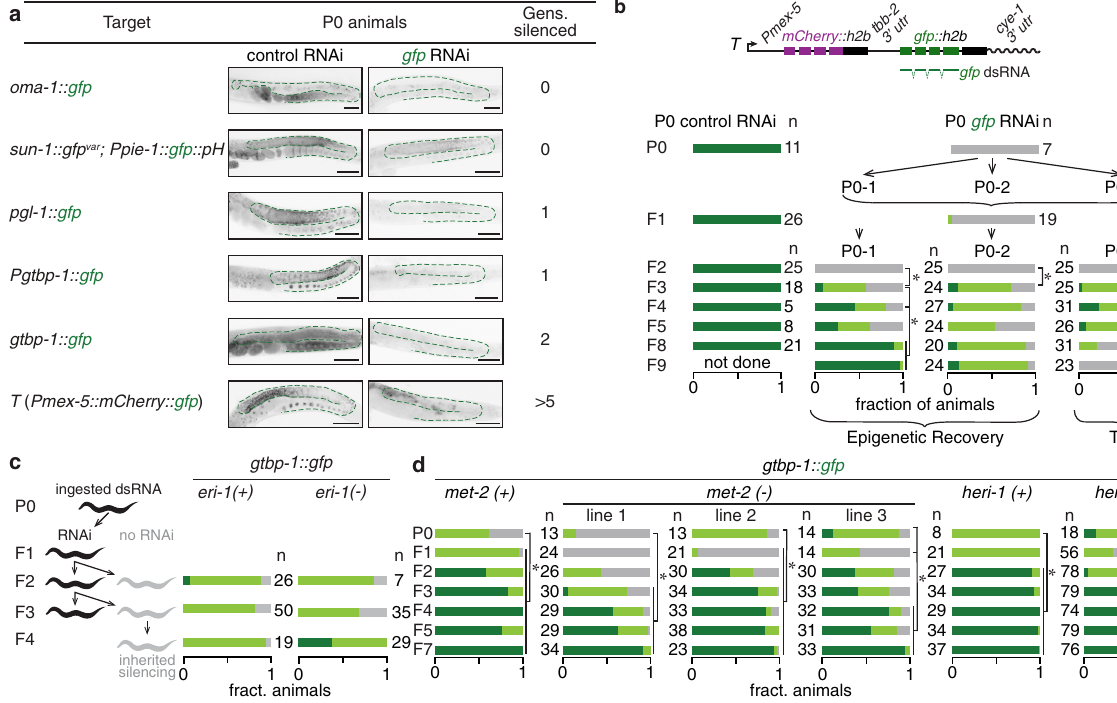
Fig. 6 Genes silenced by dsRNA in parents commonly recover from silencing in descendants. a Six target genes containing the same gfp sequence were exposed to the same sources of control RNAi or gfp RNAi. P0 animals were fed dsRNA for 24 h, and the P0 animals and their untreated descendants for up to fi ve generations (F1 – F5) were analysed. Representative images highlight the germline (green outline) of P0 animals. Numbers of descendant generations that show silencing are indicated. Note that sun-1::gfp var is also present in the animal with PH::gfp , but is not silenced because its gfp var sequence only has <14-nt of continuous homology with the gfp -dsRNA used for feeding RNAi. Scale bars indicate 50 µ m. b P0 animals expressing T were exposed to control RNAi (P0 control RNAi) or gfp -dsRNA (P0 gfp RNAi) for 24 h and silencing was analysed in P0 animals and in their untreated descendants. Upon gfp RNAi, P0 and F1 animals were each pooled for imaging but subsequent generations each descending from one P0 ancestor (P0-1, P0-2, or P0-3) were imaged as individual isolates. All generations shown were scored by imaging except F2s, which were scored by eye. While one isolate showed TEI, the other two isolates recovered expression (epigenetic recovery). As indicated with a schematic, the sequence of gfp dsRNA matches the exons of gfp coding sequence. c gtbp-1::gfp animals were fed gfp -dsRNA (black) for one, two or three consecutive generations and their untreated progeny (gray) in a wild-type ( eri-1( + ) ) or eri-1( − ) background were scored for expression of GFP. d gtbp-1::gfp hermaphrodites in wild-type ( met-2( + ) and heri-1( + ) ), met-2( − ) or heri-1( − ) backgrounds were fed gfp -dsRNA for 24 h and untreated descendants in subsequent generations (F1 – F7) were scored as in Supplementary Fig. 8c. Feeding RNAi of other strains was performed concurrently, thus data for gtbp-1::gfp here is the same as in Supplementary Fig. 8c. In heri-1(-) animals, the statistical difference between P0 and F1 – F2 is due to increased silencing, but that between P0 and F3 – F7 is due to decreased silencing. Most animals fed control RNAi and descendants showed bright expression of GFP (except 2 out of 45 F5 descendants and 1 out of 37 F7 descendants of heri-1(-) animals that showed dim expression). Number of animals scored ( n ) are indicated. Asterisks indicate P < 0.05 using χ 2 test. Also see Supplementary Fig. 8. Source data are provided as a Source Data fi